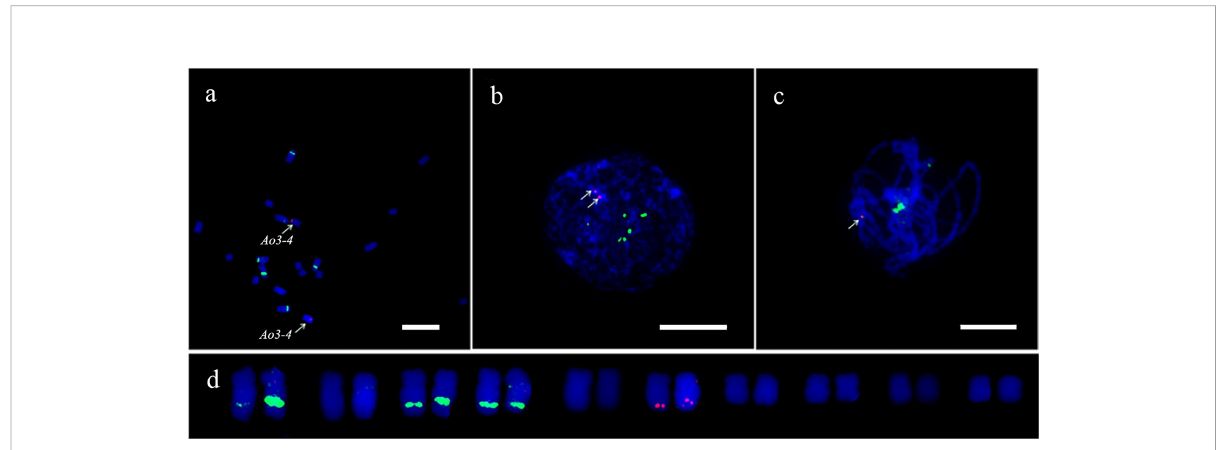
FIGURE 6 FISH analysis of the Ao3-4 gene to evaluate the quality of the sequence assembly. FISH mapping of the Ao3-4 gene using the 5 kb probe (red) and 45S rDNA probe (green) at mitotic metaphase (A) , interphase (B) , and meiotic pachytene (C, D) The karyotypic analysis. Scale bar = 10 m m.